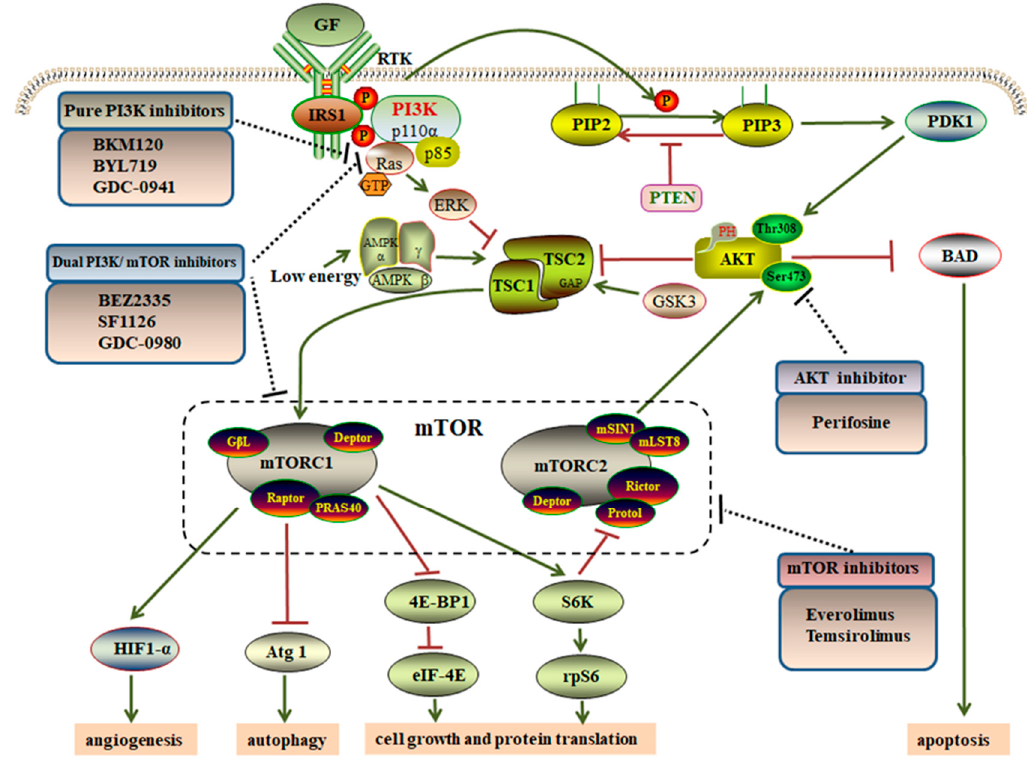
Figure 2. A schematic overview of the PI3K/AKT/mTOR pathway and inhibitors targeting different parts of the pathway in GISTs. Activation of RTKs by external growth factors leads to activate the PI3K/AKT/mTOR pathway, which directly and indirectly results in tumorigenesis, the inhibition of apoptosis and autophagy, the activation of protein translation, as well as angiogenesis. Inhibitors of